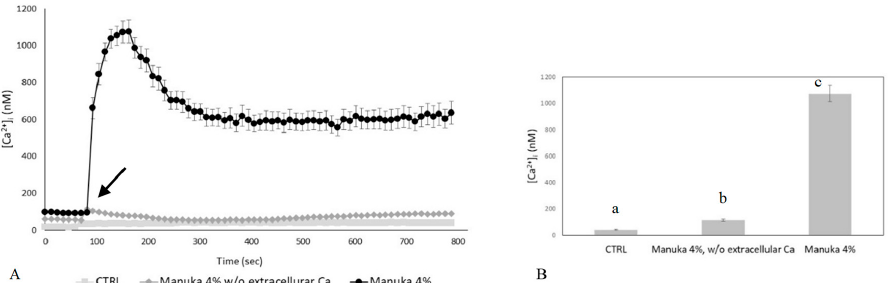
Figure 2. The Ca 2+ response to manuka honey requires extracellular Ca 2+ entry. ( A ) The Ca 2+ response to 4% v / v manuka honey was abolished in Ca 2+ -free medium. Control cells, which were not exposed to